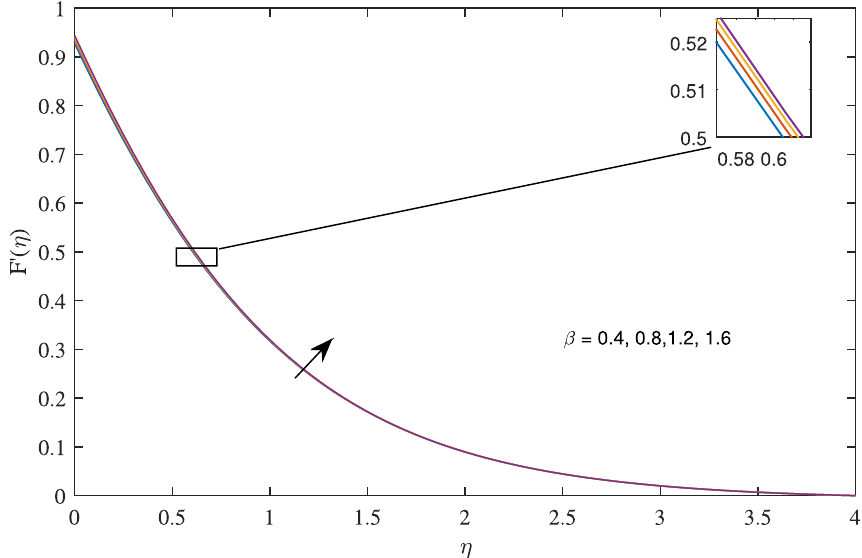
1 , h 0.5 , ζ 0.1 , N 0.1 0.2 , φ rd = = = = =